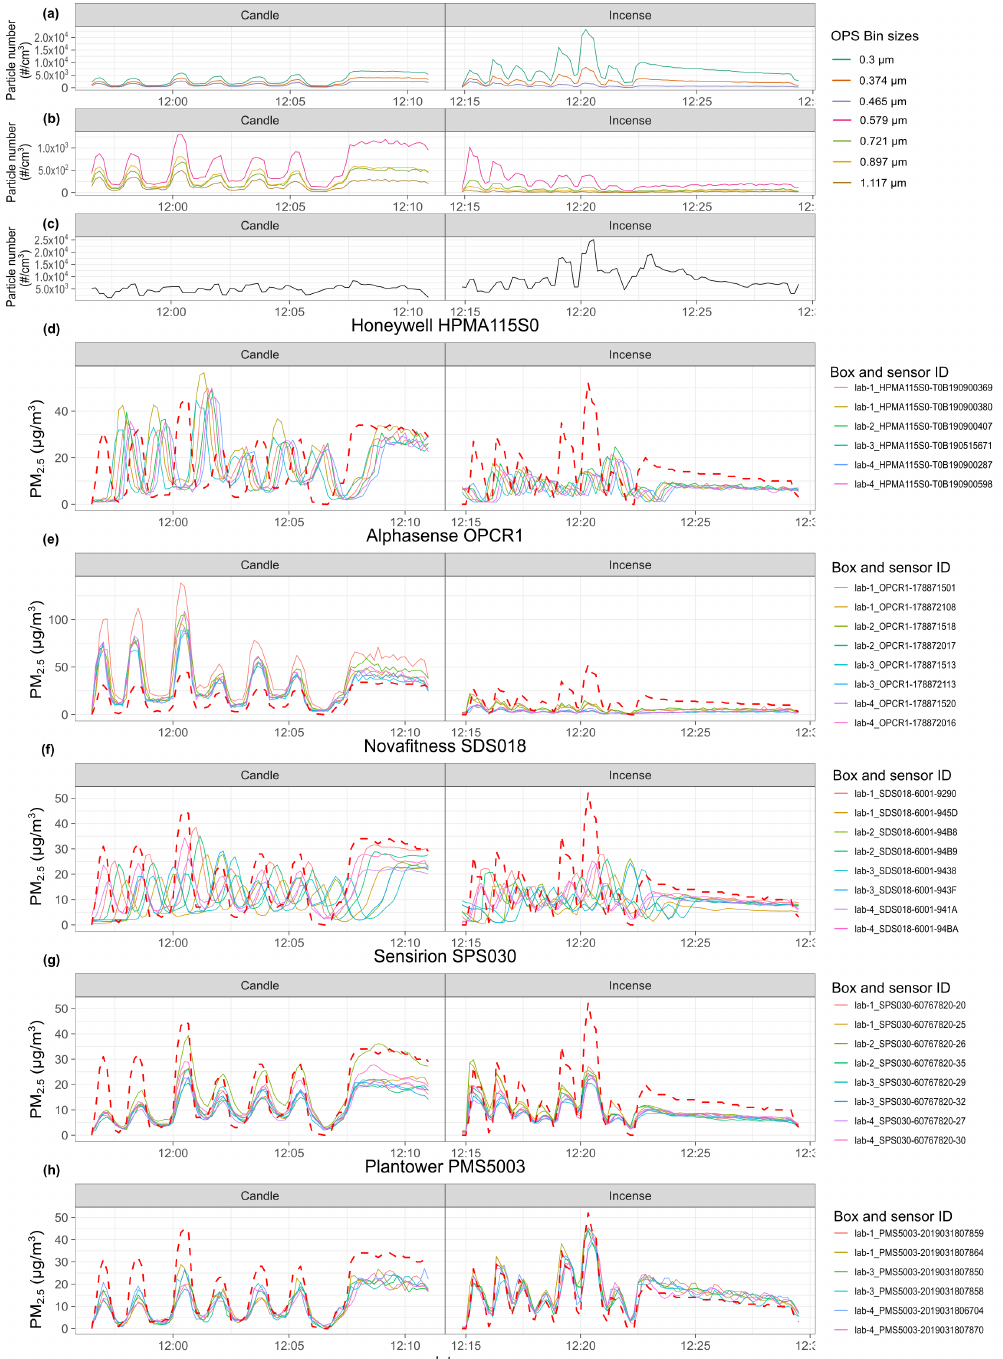
Figure A13. Time series of experiment 5. From top to bottom: ( a , b ) TSI 3330 OPS Bin size distribution; ( c ) Nanotracer ultrafine particles number concentration #1/cm 3 ; ( d – h ) PM 2.5 of the sensors for each model of sensor, against DustTrak (red dotted line). The sensors are named according to the box they are placed in and their serial